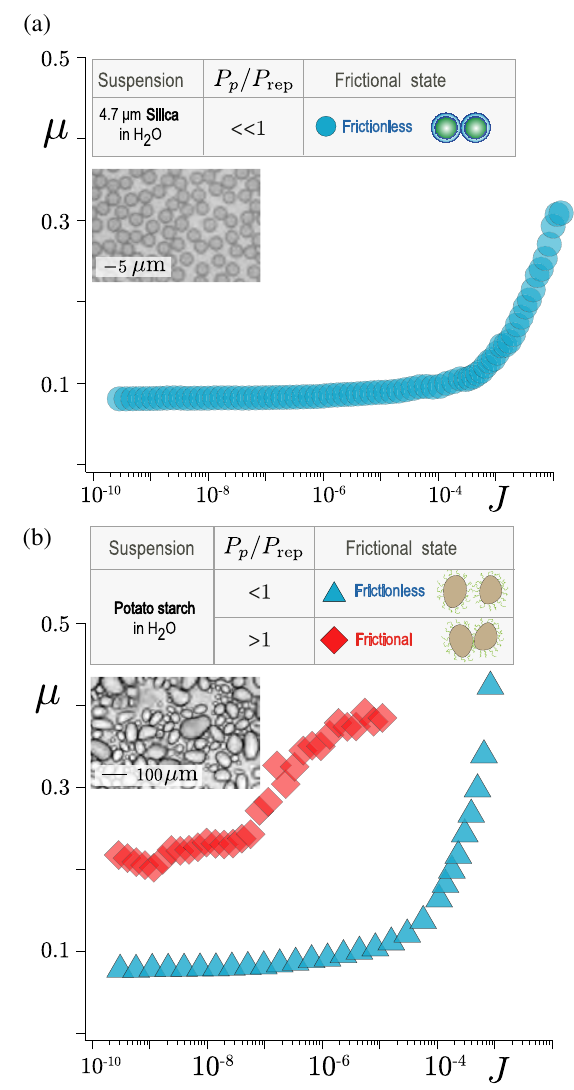
FIG. 4. Towardmorecomplexcolloidalsuspensions.Suspension friction coefficient μ versus viscous number J (a) for a suspension of slightly Brownian silica particles of diameter d ¼ 4 . 7 μ m ¼ 20 Pa ( P ≪ 1 ) =P immersed in water and measured at P p p rep and (b) for a suspension of potato-starch particles immersed in ¼ 10 Pa, P ≪ 1 ) and large =P water and measured at small ( P p p rep ¼ 500 Pa, P ≫ 1 ) particle =P ( P p p rep